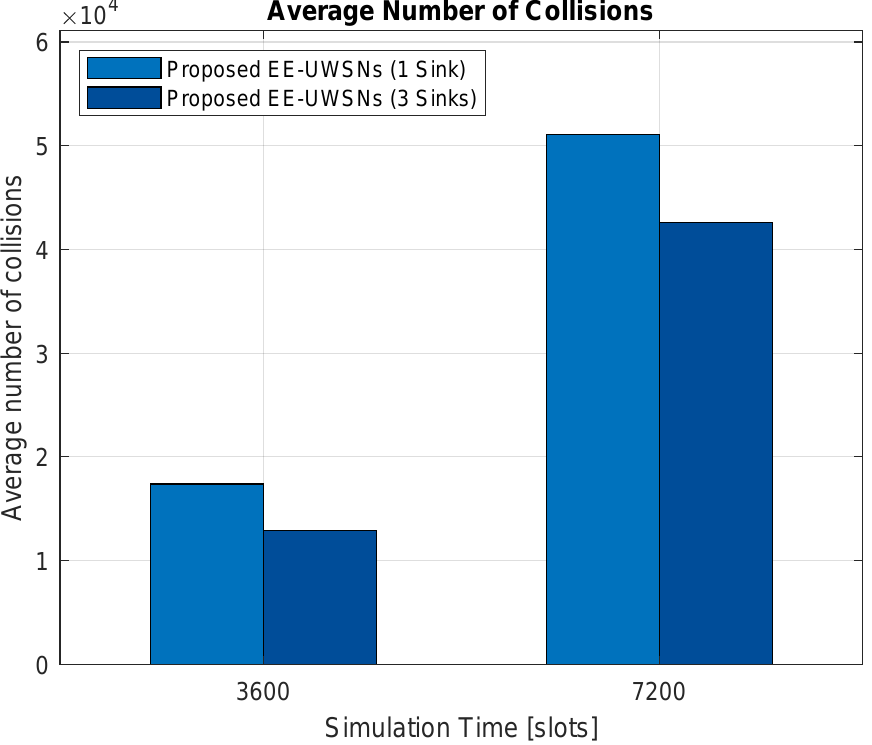
Figure 17. The effect of changing the number of sinks on the number of